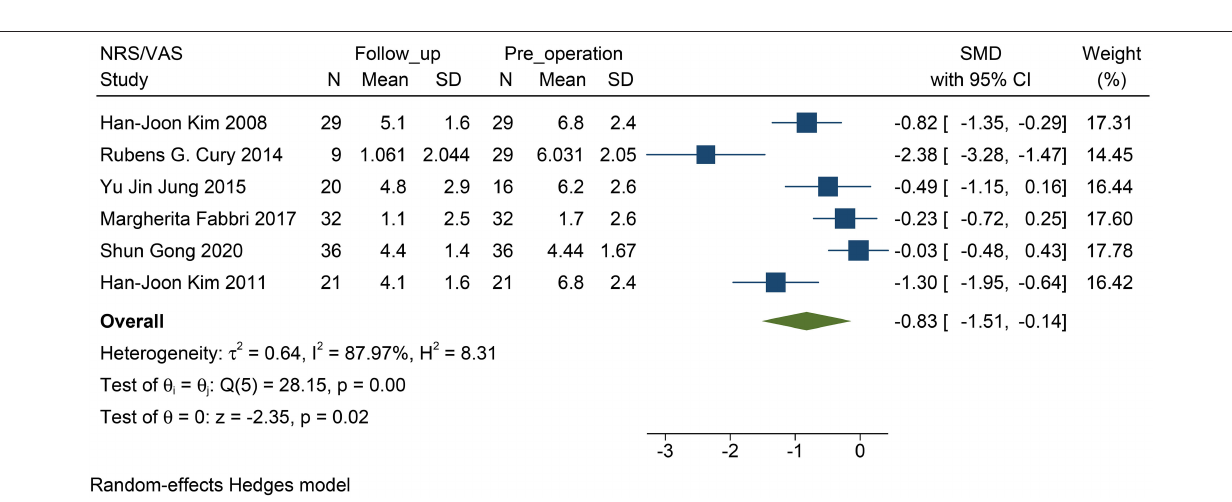
FIGURE 3 | Forest plots of pain severity: pain severity assessed by the VAS/NRS decreased significantly after STN-DBS. NRS, numerical rating scale; VAS, visual analog scale; STN-DBS, subthalamic nucleus deep brain